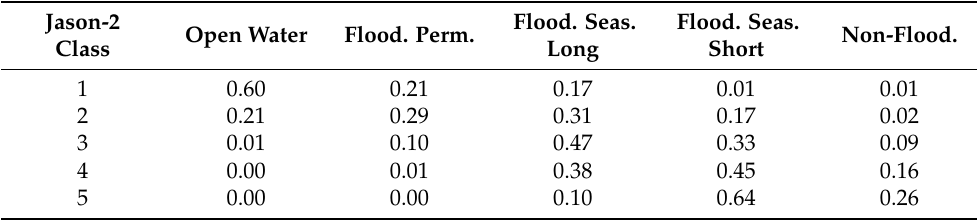
Figure 4. Seasonal variations in the mean backscattering coefficient and its associated deviation at Ku-band from Jason-2 (2008–2016) for each class when considering ( a ) 3, ( b ) 4, ( c ) 5 classes. Table 2. Confusion matrix between 5 classes of RA backscattering coefficients from Jason-2 and the 5 land type classes identified on the study